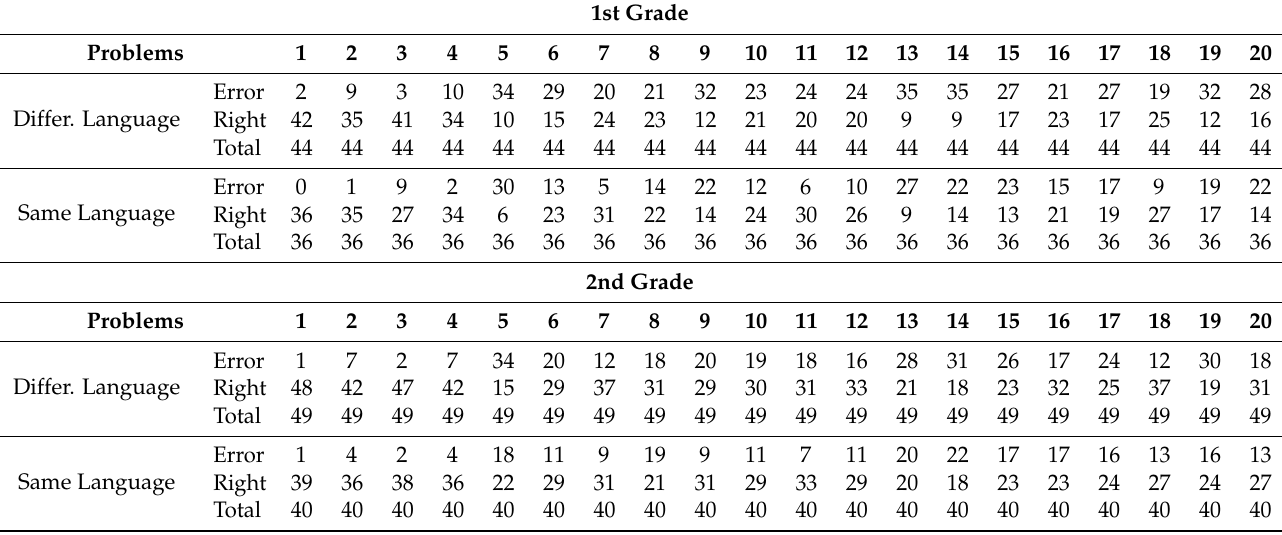
Table 3. Distribution of students per grade (1st and 2nd graders), mother tongue/language of instruction and wrong/right